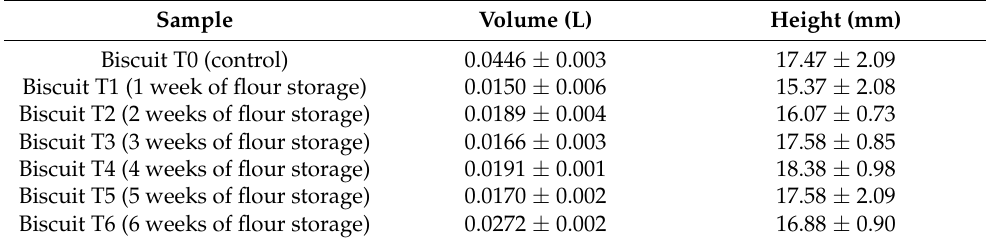
Table 4. Results of biscuit characterization expressed as the mean of the three replicates ± SD.